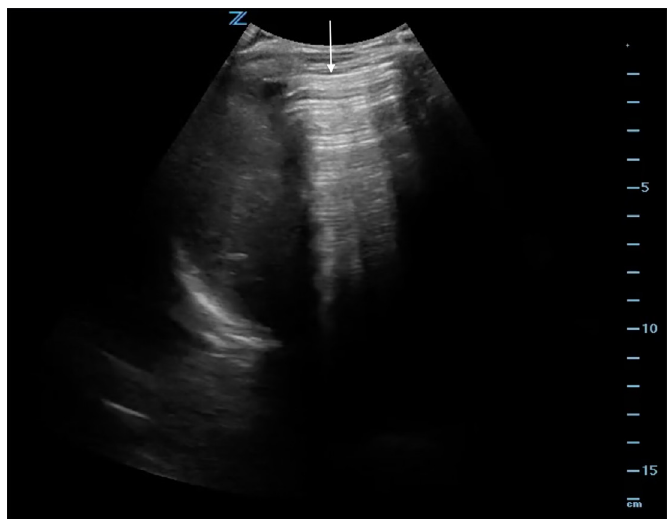
Image 2. Ultrasound image from Case 2 showing enhanced peritoneal stripe sign in the right upper quadrant, indicative of free intraperitoneal air (arrow).